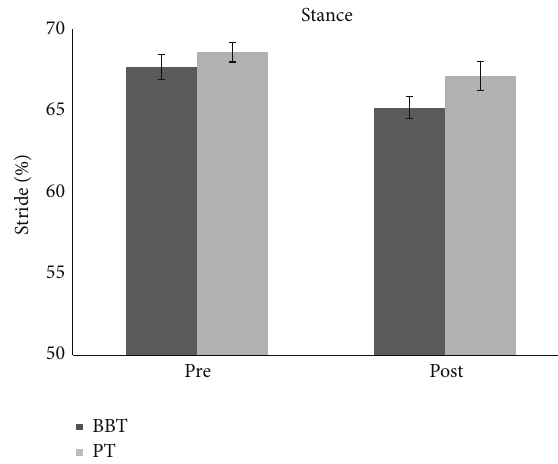
Figure 2: The graph shows the effects of BBT and PT (dark grey and light grey, resp.) on percentage of stance phase with respect to entire stride phase. Error bars indicate the standard error. PT: physical therapy; BBT: blindfolded balance training.